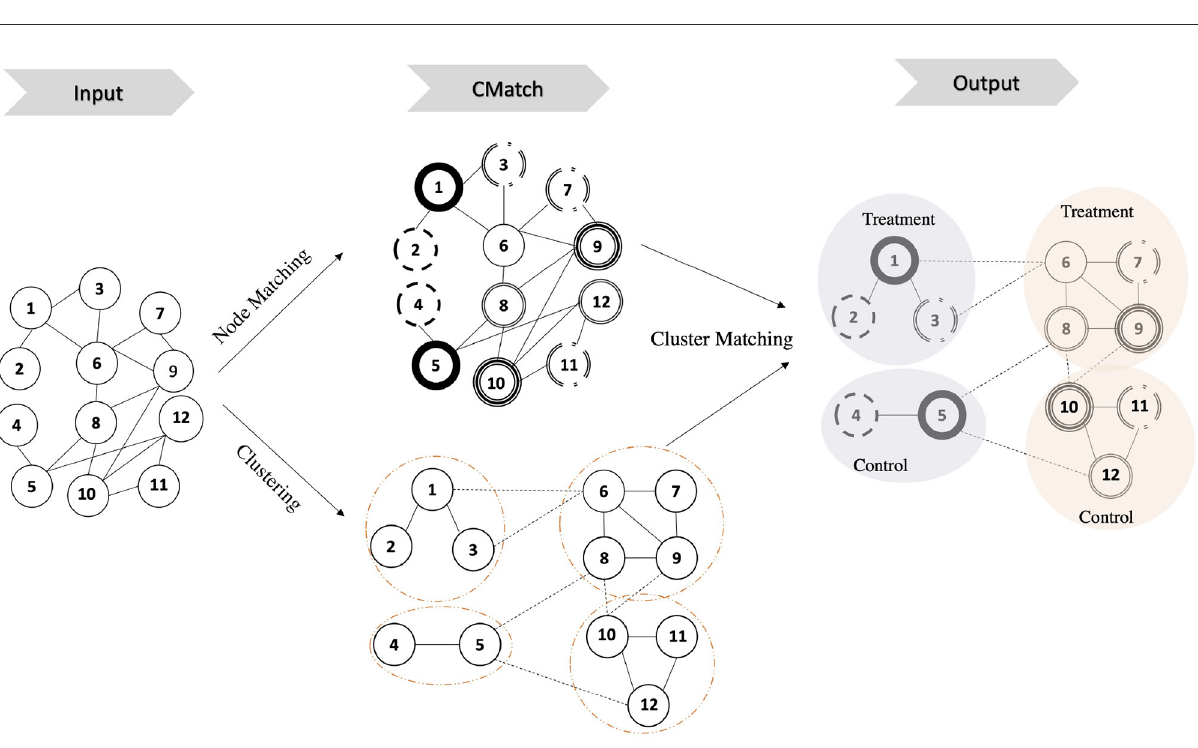
FIGURE3 Illustration of CMatch framework for minimizing interference and selection bias in controlled experiments. Input : a graph of nodes and the connection between them. CMatch : node and cluster matching; the dashed circles indicates the clusters. Matched nodes are represented with a similar circle border. Output : assigning the matched cluster pairs to treatment and control randomly; circles with the same color represent matched